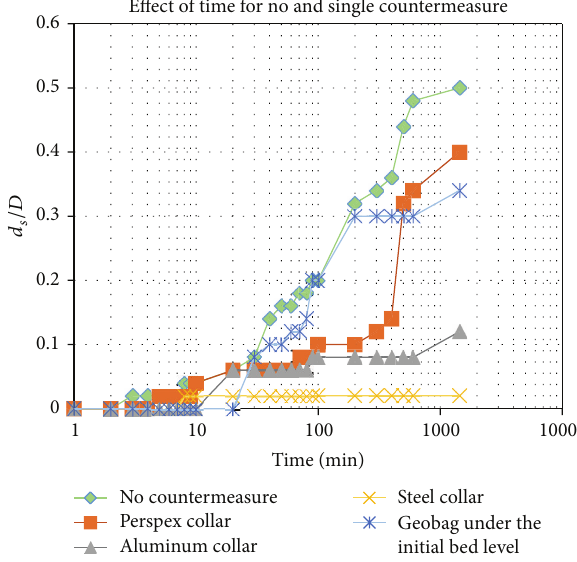
Figure 4: Dimensionless scour depth versus time, for the following scenarios: with countermeasure and without countermeasure (Pile